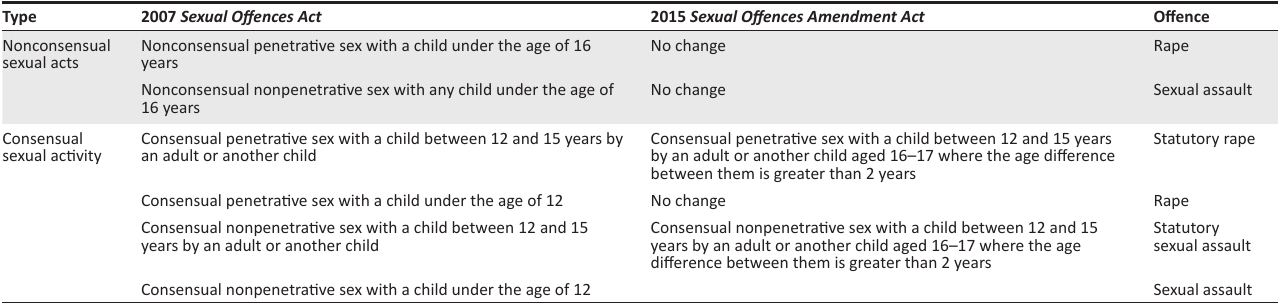
TABLE 1: Sexual activity with teenagers and children and interpretation under the Criminal Law (Sexual Offences and Related Matters) Amendment Act 32 of 2007 and Criminal Law (Sexual Offences and Related Matters) Amendment Act 5 of 2015, respectively.